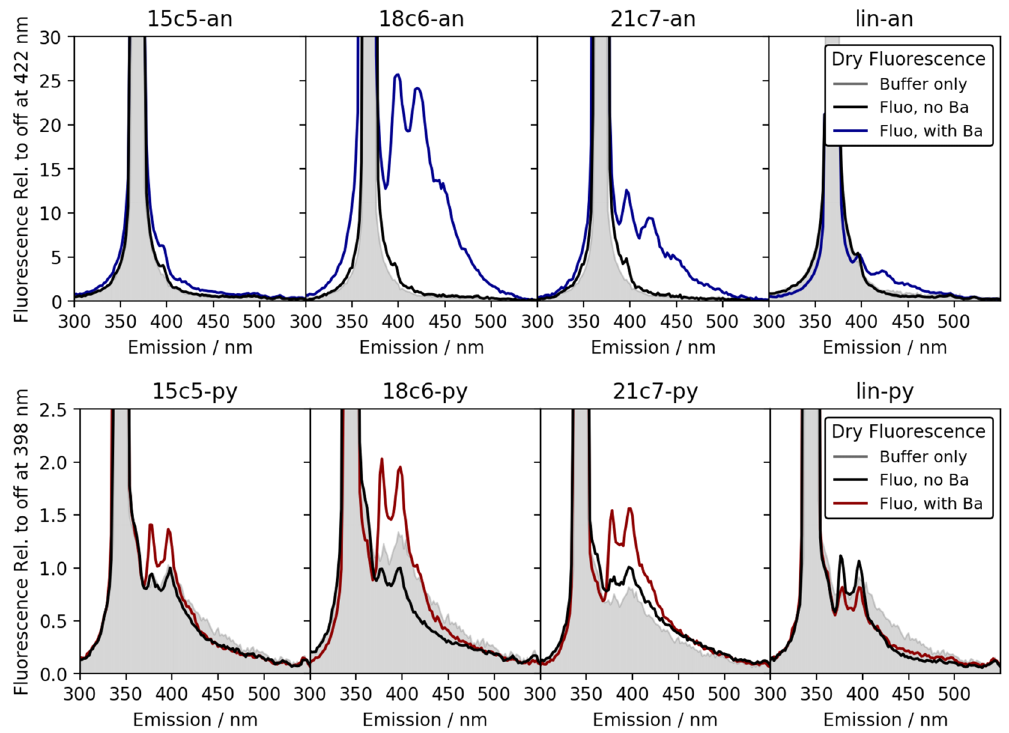
Figure 6. Fluorescence response of dried films of fluorescent barium sensing molecules in buffer. In each panel the grey line shows the emission contribution from scattering and fluorescence in the buffer alone. The black line shows the emission contribution from un-chelated fluorophore in buffer, and the coloured lines show the response with barium